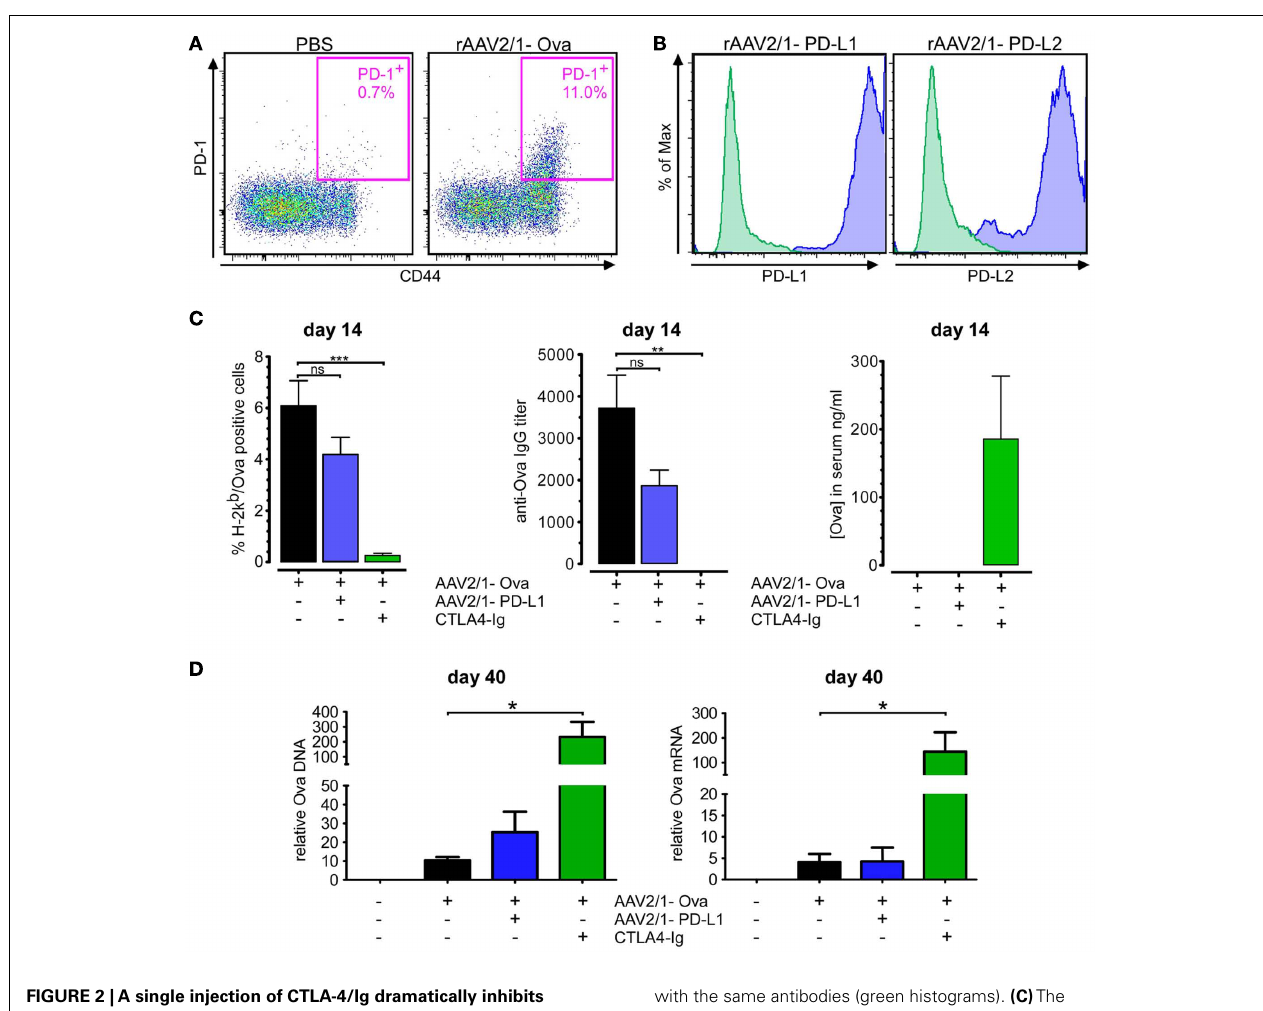
FIGURE 2 |A single injection of CTLA-4/Ig dramatically inhibits immune responses and improves transgene persistence at early time points. (A) Mice were injected as in Figure 1 with 1 × 10 11 vg rAAV2.1-Ova in the gastrocnemius muscles at day 0. Splenic CD8 + T cells were analyzed at day 14 by flow cytometry for expression of CD44 and PD-1. (B) rAAV2/1-PD-L1 and rAAV2/1-PD-L2 vectors were designed, produced, and tested for their capacity to transduce HEK-293 cells in vitro . For this, cells were analyzed by flow cytometry 3–5days after their transduction with 1/10th dilution of the concentrated virus stocks. Controls correspond to unmanipulated HEK-293 parental cells stained